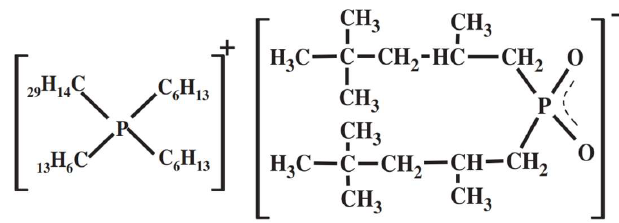
Figure 1. The structure formula of Cyphos IL 104 [R4PA].